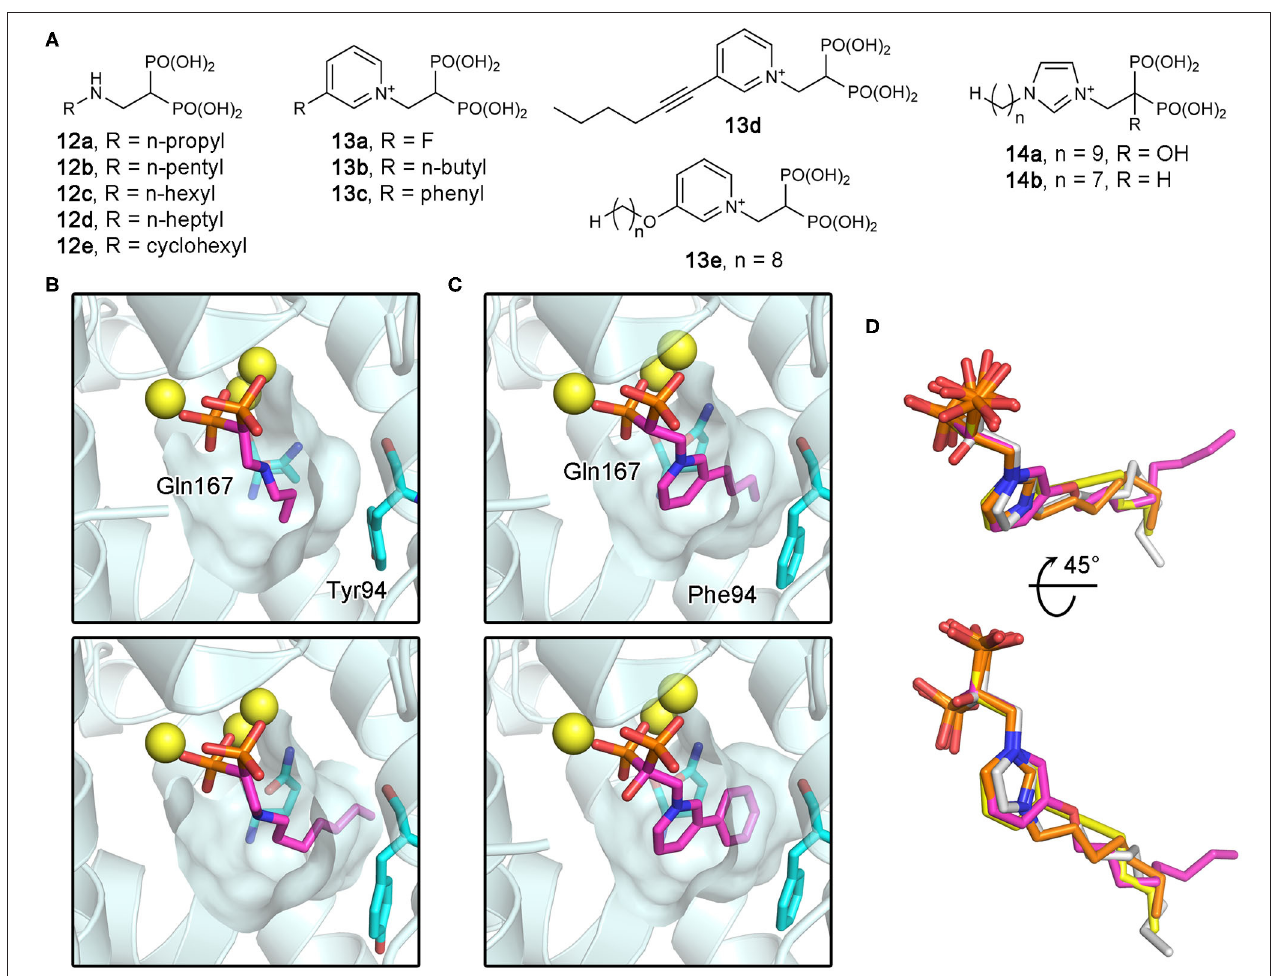
FIGURE 12 | Bisphosphonate inhibitors of trypanosomatid FPPS and their target binding. (A) Examples of exploratory bisphosphonate inhibitors of trypanosomatid FPPS. (B) The binding of 12a (top panel; PDB ID: 4DXJ) and 12d (bottom; PDB ID: 4DWG) to Tc FPPS. The conformational changes in Tyr94 and Gln167 induced by 12d results in an increase in the volume of the binding site hydrophobic pocket. (C) The binding of 13b (top; PDB ID: 4JZX) and 13c (bottom; PDB ID: 4JZB) to Lm FPPS. (D) Superimposed binding poses of 13d (yellow; PDB ID: 5AEL), 13e (magenta; PDB ID: 3EFQ), 14a (white; PDB ID: 5AFX), and 14b (orange; PDB ID: